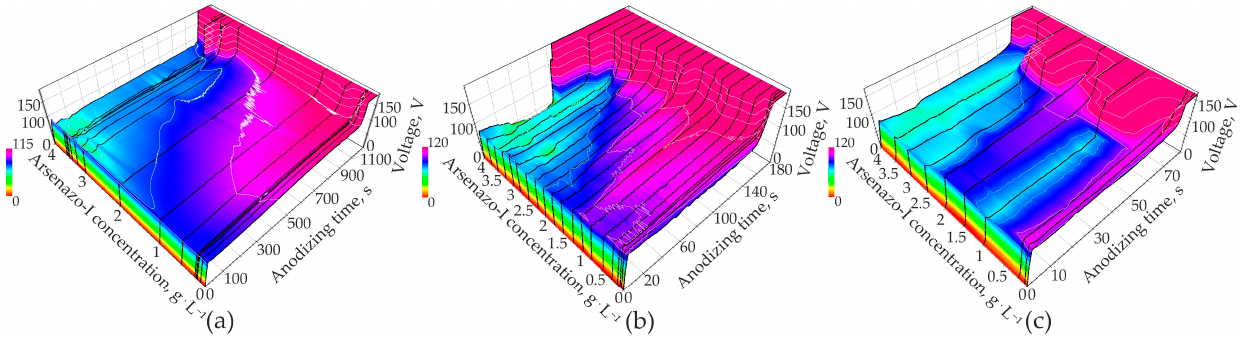
Figure 2. Dependences of anodic voltage on time and concentration of arsenazo-I additive for current densities ( a ) 15, ( b ) 100 and ( c ) 200 mA·cm − 2 .